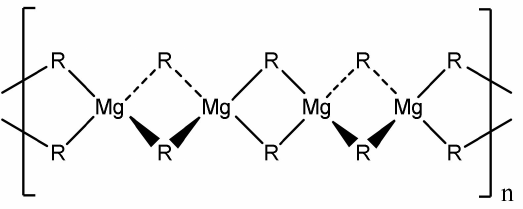
Figure 1. Polymeric structure of organomagnesium alkyls